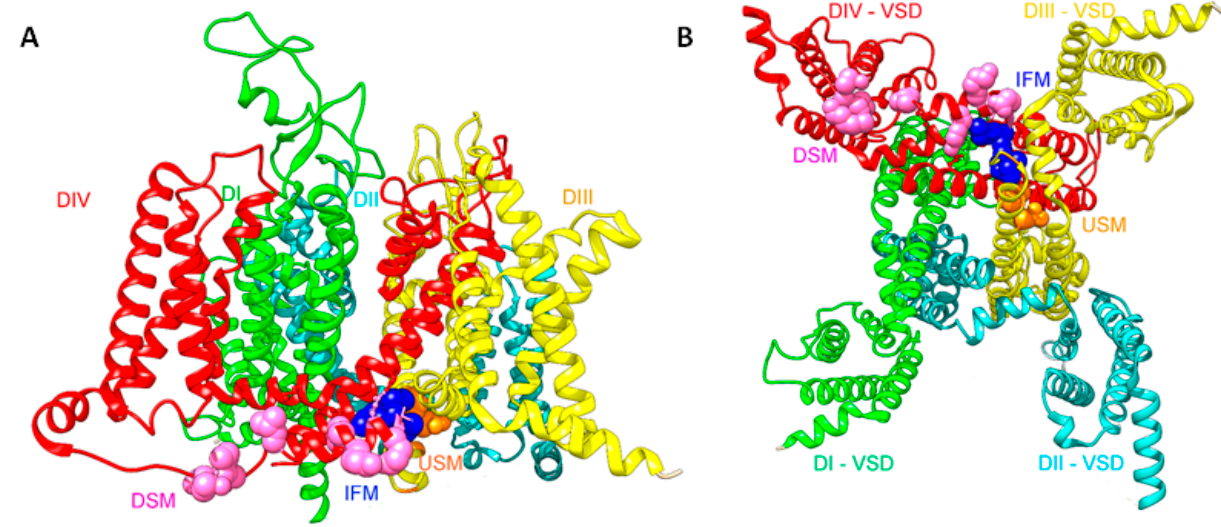
Figure 1. ( A ) A side view of the structure of the full length hNa v 1.5 (PDB ID code 6LQA) [9]. DI is shown in green, DII in cyan, DIII in yellow, and DIV in red. The DIII-DIV linker IFM motif is shown as navy-blue spheres. Upstream (USM) and downstream (DSM) mutations are shown as orange and pink spheres respectively. ( B ) A bottom view shows the inactivation gate and the missense mutations that target this area. The same color code is used as in A.